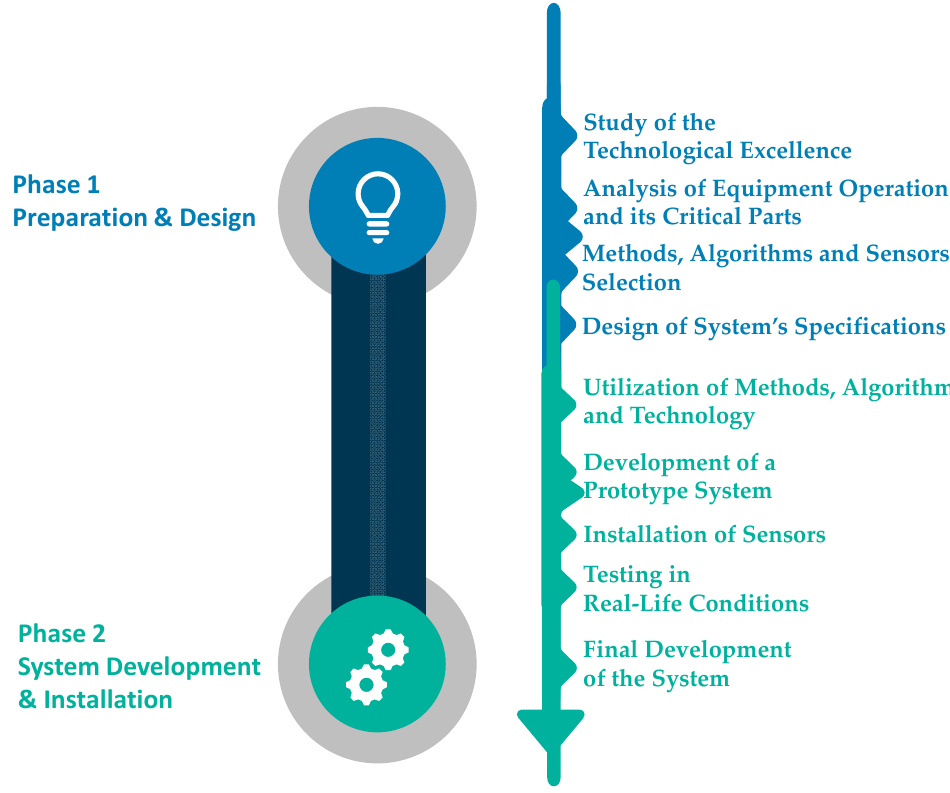
Figure 1. The Methodological Approach for Developing the Predictive Maintenance System.